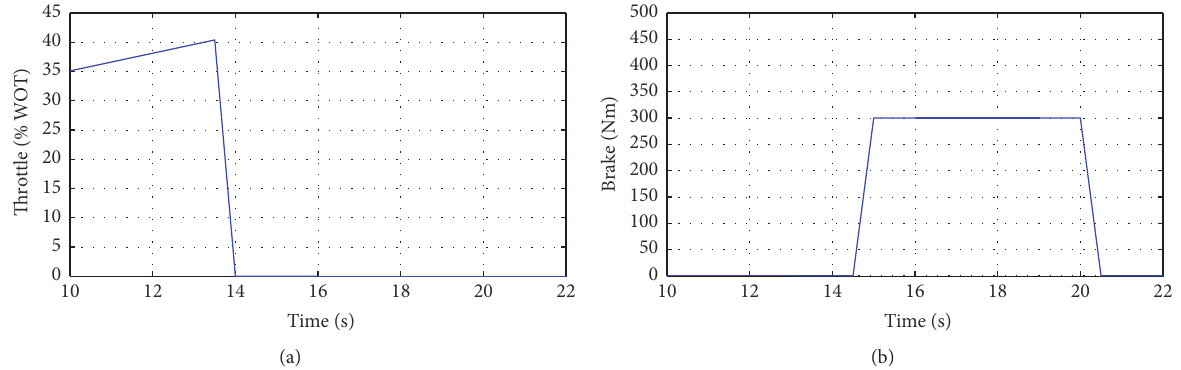
Figure 9: Throttle and brake torque inputs for accelerating and hard braking scenario.